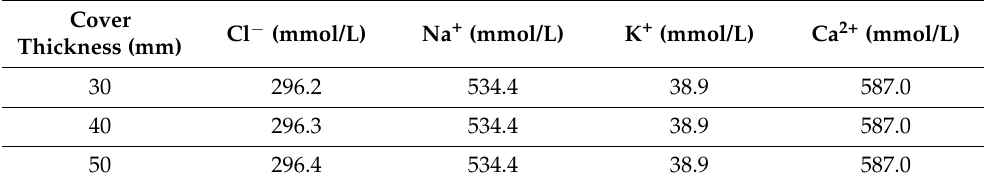
Table 4. Mean ionic concentrations in the vicinity of steel after the electrochemical treatment of dif- ferent cover thicknesses.